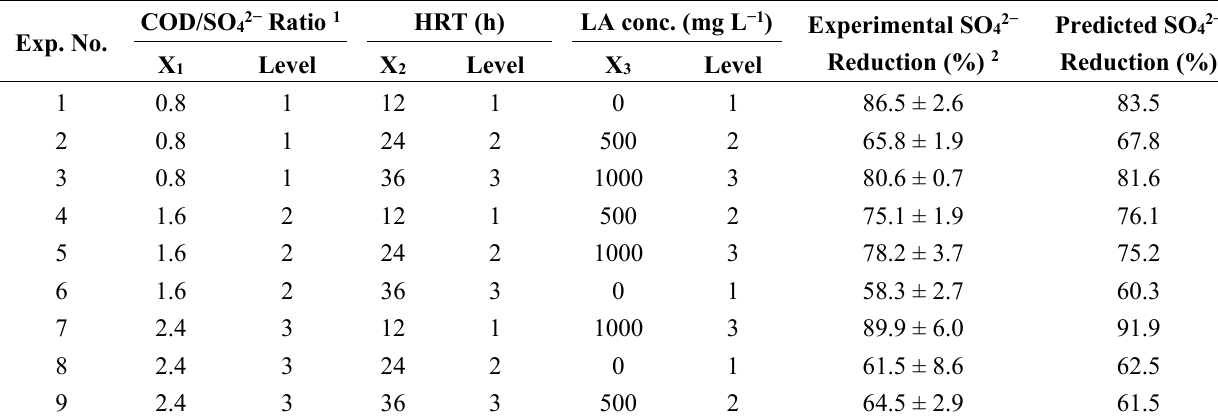
Table 2. Design matrix for experimental factors and corresponding response function at different factor